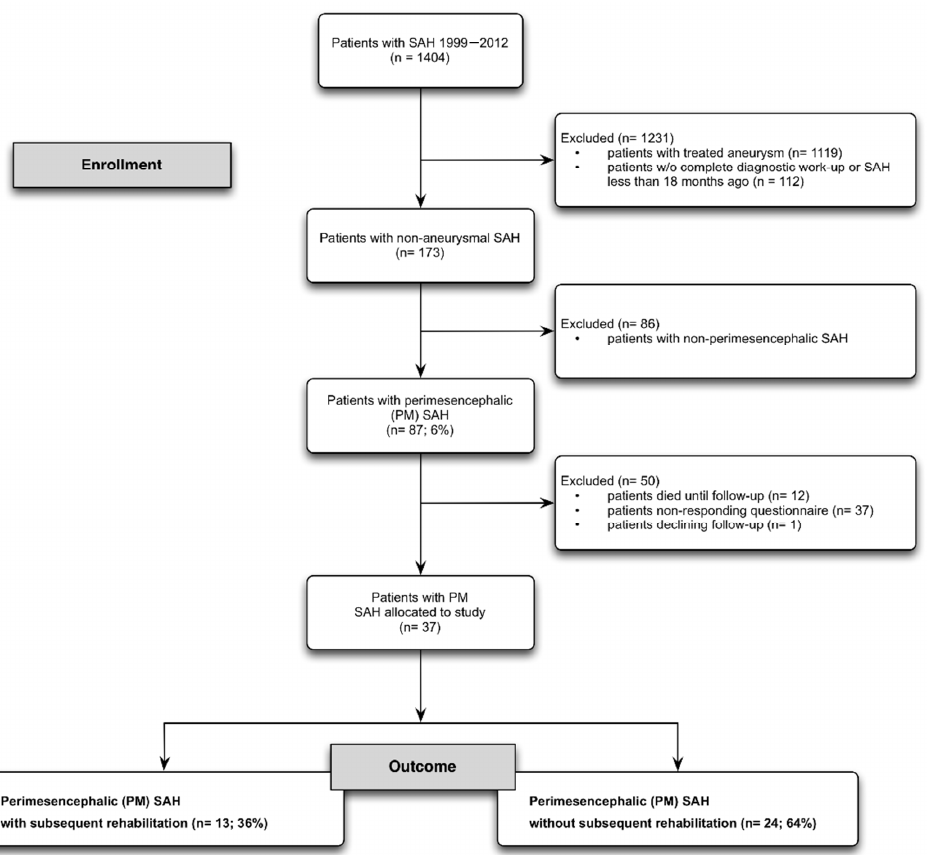
Figure 1. Flow diagram with detailed information about enrollment and long-term follow-up. From over 1400 patients with SAH, 87 patients with PM SAH were identified. Overall, a good response rate was achieved, especially against the background of patients suffering from NASAH starting 20 years